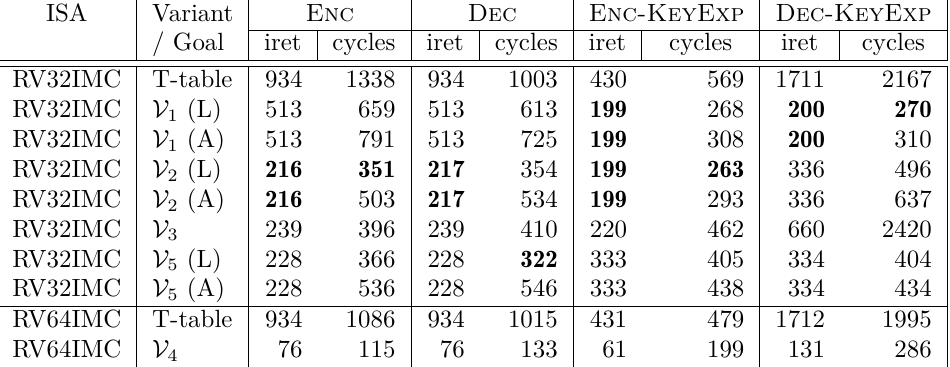
Table 4: Execution metrics for each ISE variant on the Rocket core. Note that the 64-bit V 4 uses the 64-bit Rocket core; all others use the 32-bit Rocket